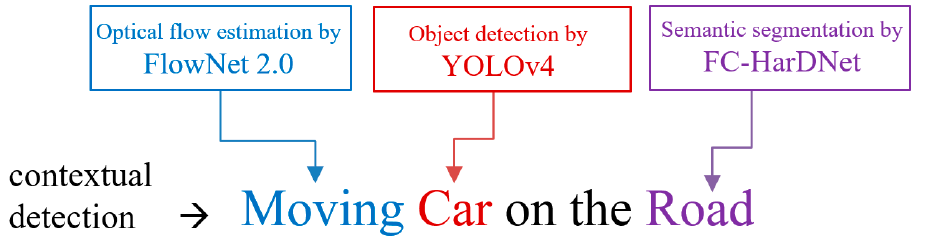
Figure 1. The concept of contextual detection in our project.